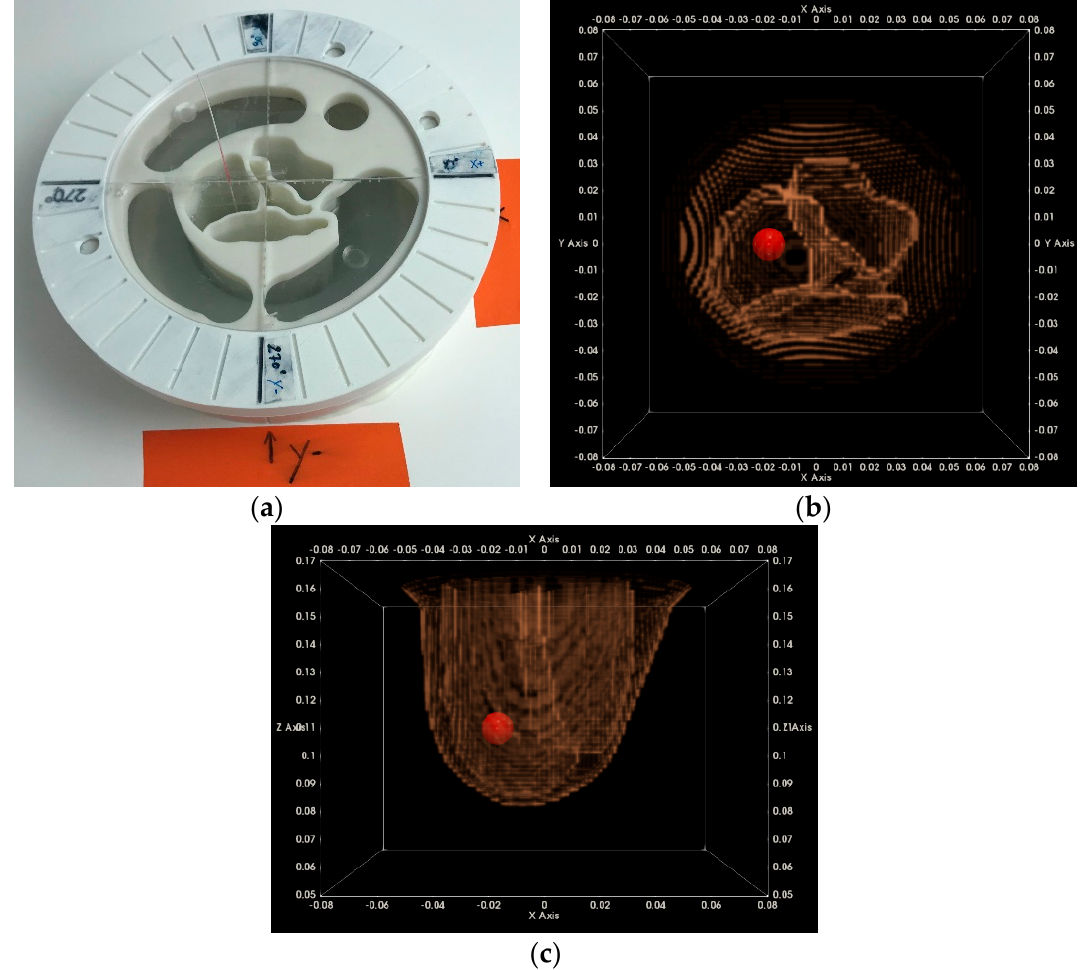
Figure 19. Experimental setup for the breast rotational position #2: ( a ) Photo—Top view of the breast phantom, installed on the examination table; ( b ) Schematic definition of the tumor location (red sphere of diameter 14 mm, equal to the average diameter of the microlobulated tumor phantom) in the fibroglandular tissue of the breast (the outer surface of both the fibroglandular mold and the outer breast surface mold are depicted with orange color)—Top View; ( c ) Schematic definition of the tumor location in the fibroglandular tissue of the breast—Side View.